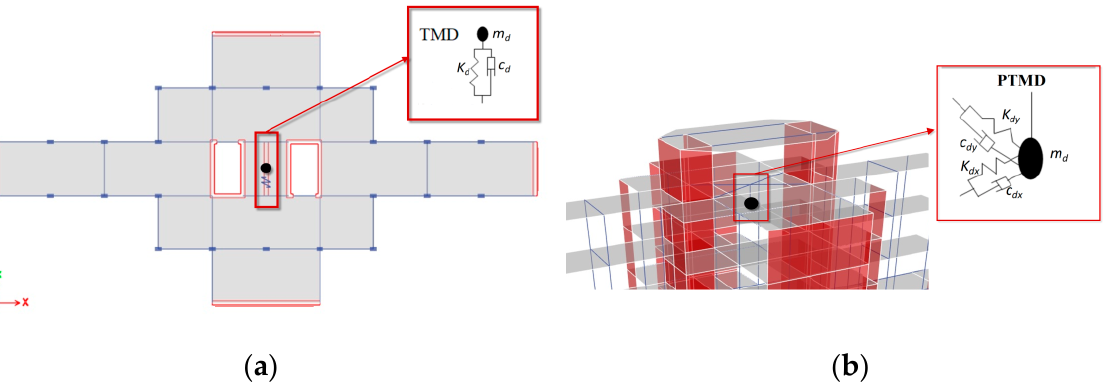
Figure 6. Modeling configuration of ( a ) TMD for low-rise and mid-rise buildings, ( b ) PTMD for high-rise building. Table 7. Response of the high-rise building for the TMD and PTMD configuration.